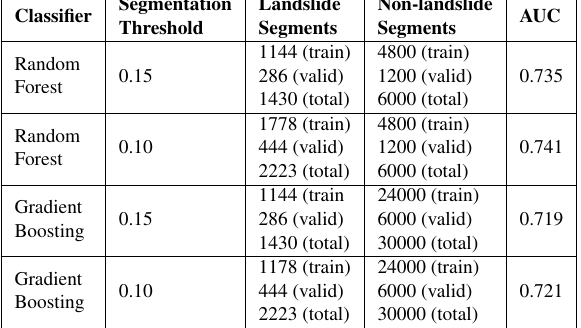
Table 3: 5-Fold Cross-validation Result